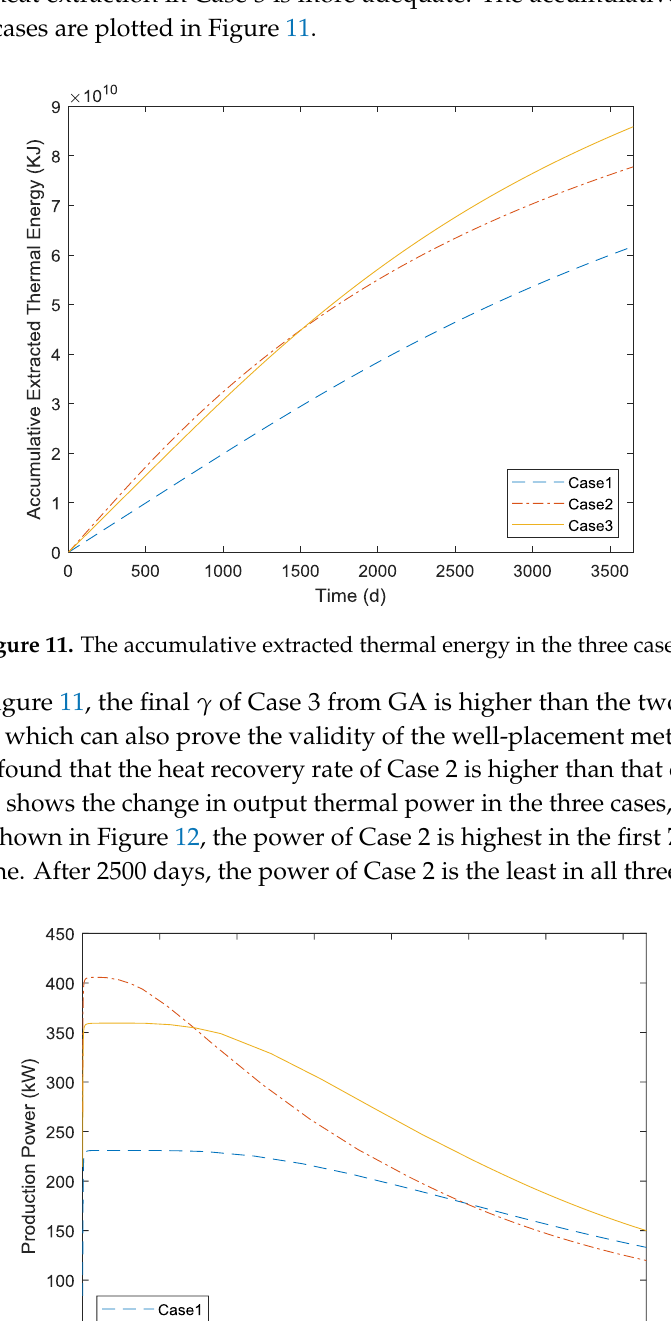
Figure 10. The temperature variations of three cases. The top is Case 1, the middle is Case 2 and the bottom is Case 3 (optimization result).